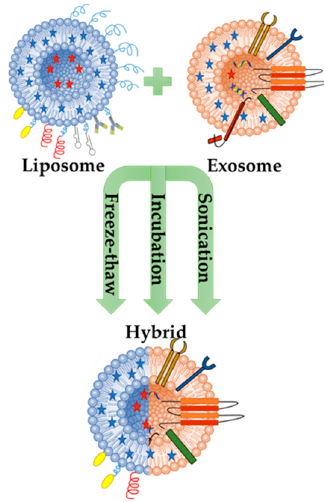
Figure 2. Schematic illustration of hybrid exosome-liposome nanovesicles formed by three main methods: sonication, incubation, and freeze-thaw cycles.